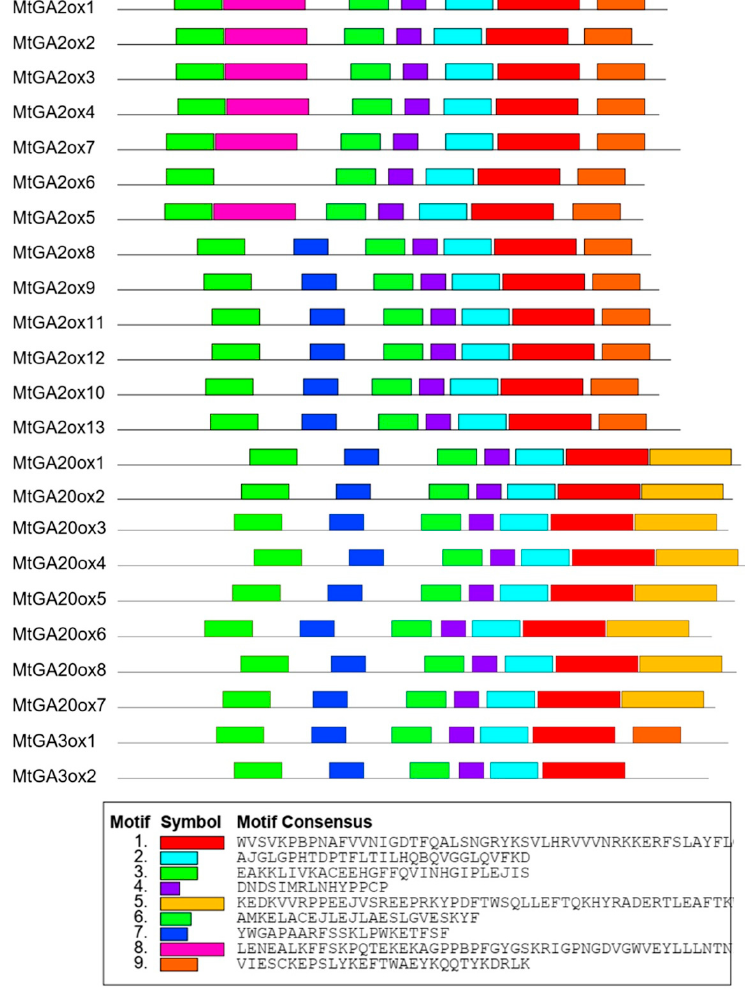
Figure 2. Motifs composition of the MtGA20ox, MtGA3ox, and MtGA2ox proteins. The conserved motifs are predicted by MEME. The different motifs are represented by colored boxes. Motif 3 is representative DIOX_N domain. Motif 1 and motif 2 are representative 2OG-FeII_Oxy domain.